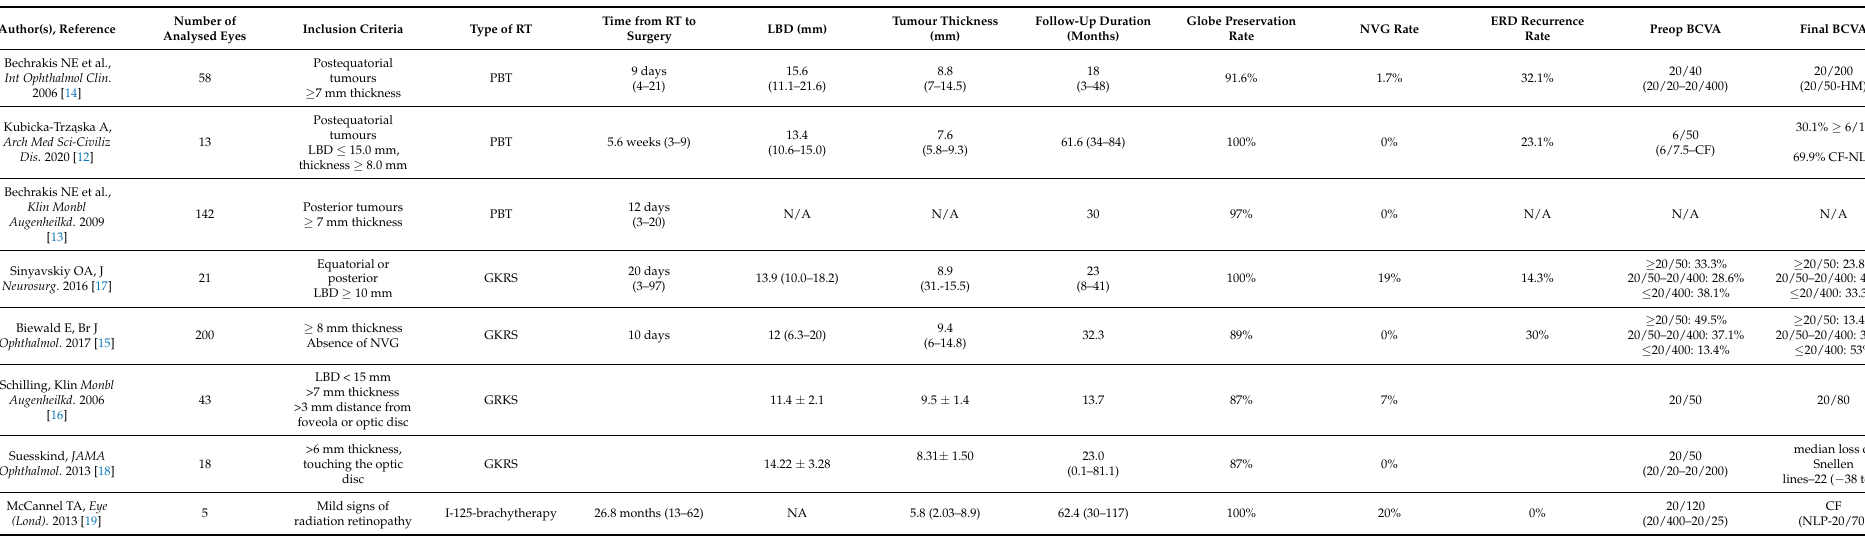
Table 1. Summary of studies on secondary endoresection following different types of radiotherapy. CF = counting fingers; ERD = exudative retinal detachment; GKRS = gamma knife radiosurgery; HM = hand movement; LBD = largest basal diameter; NVG = neovascular glaucoma; PBT = proton beam therapy; RT = radiotherapy; BCVA = best corrected visual acuity.